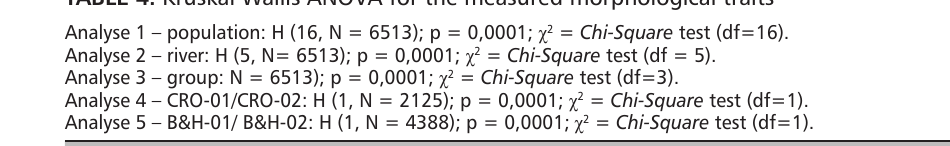
taBle 4. Kruskal-Wallis ANOVA for the measured morphological traits Analyse 1 – population: H (16, N = 6513); p = 0,0001; χ 2 = Chi-Square test (df=16). Analyse 2 – river: H (5, N= 6513); p = 0,0001; χ 2 = Chi-Square test (df =